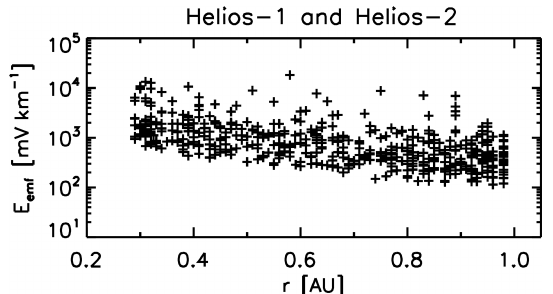
Figure 5. Comparison of the electromotive force magnitude com- puted from the Helios-2 of plasma and magnetic field fluctua- tion data (in black) and that from the mean-field model using the Helios-2 mean field data (in gray) for the shock crossing event on 18 April 1978 (the same event as that in Fig. 1). Figure is produced using the data in Bourdin et al. (2018). Table 1. Transport coefficients estimated from a 12h solar wind interval including an interplanetary shock (active solar wind) and a quasi-stationary turbulent state (quiet solar wind) after Bourdin et al. (2018). Coefficient